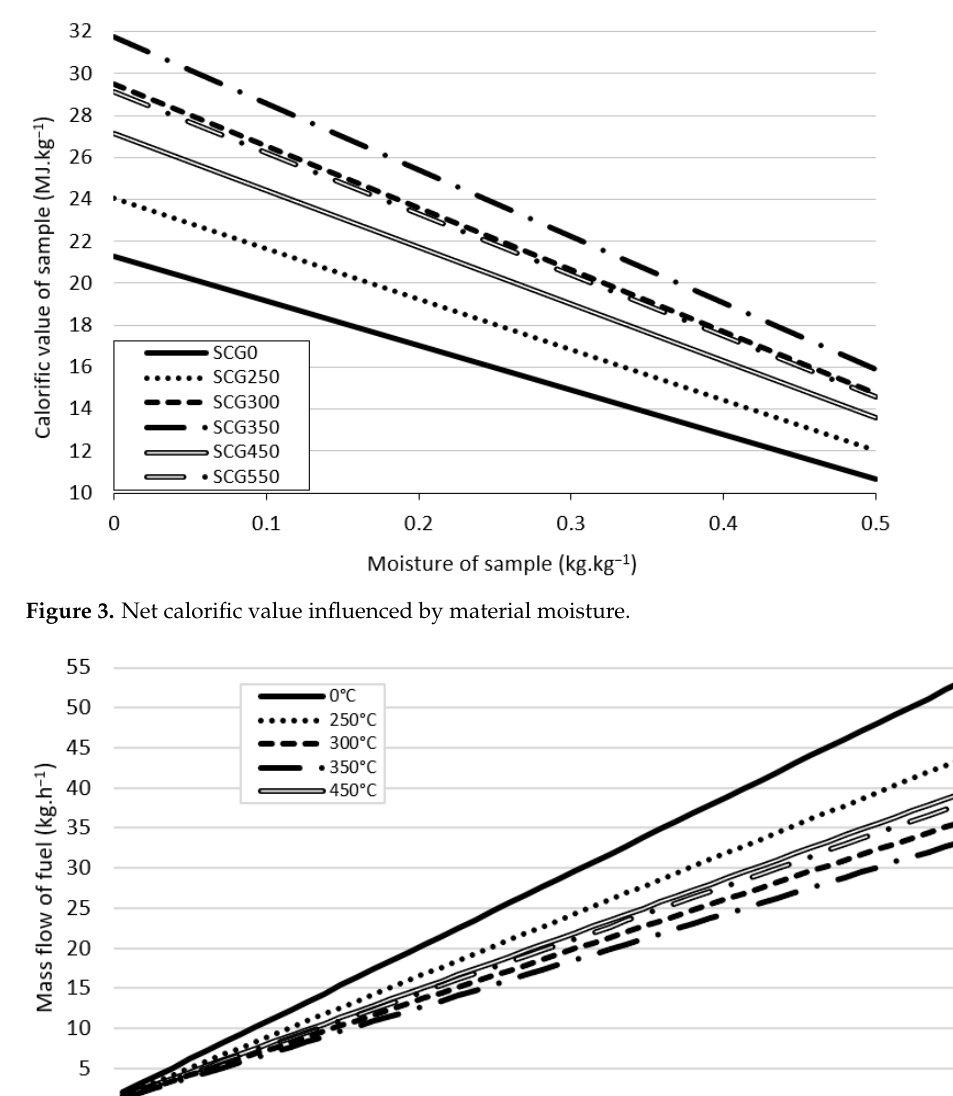
Figure 3. Net calorific value influenced by material moisture.